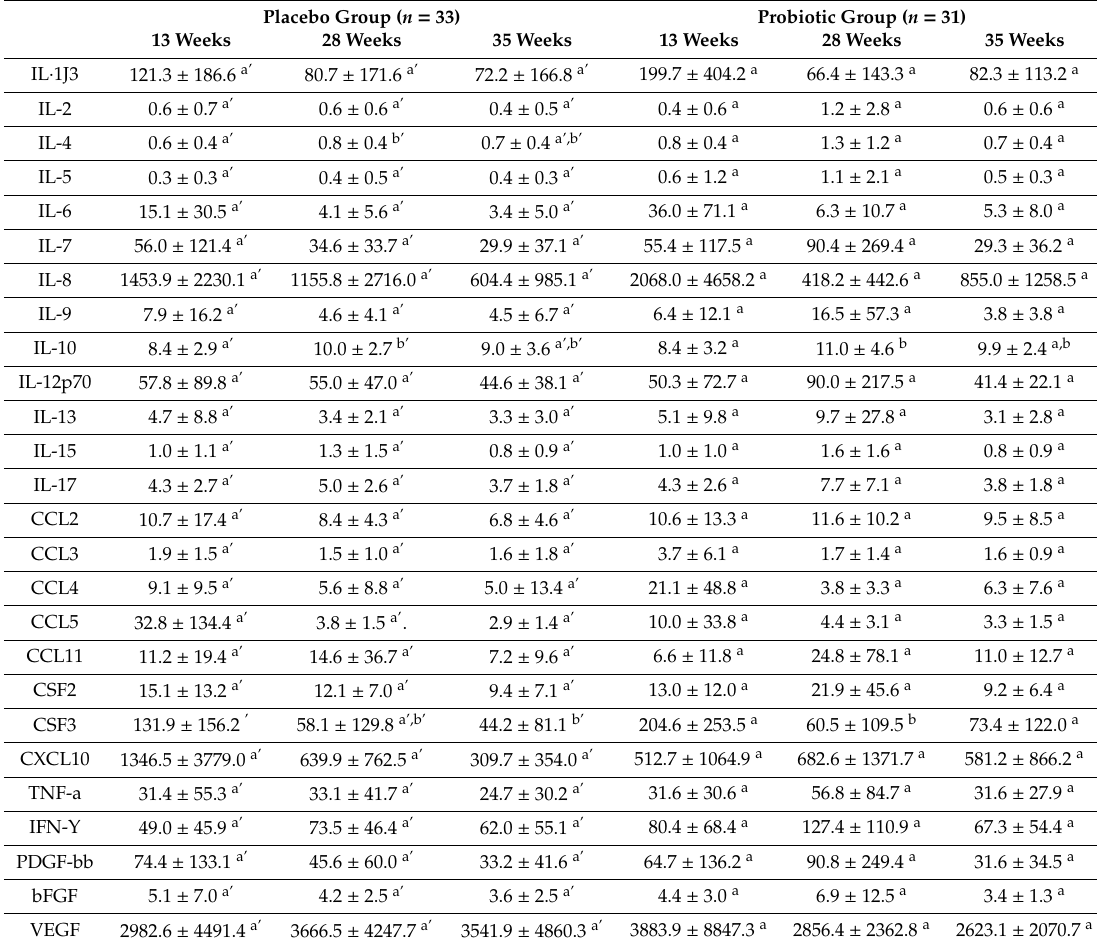
Table 5. Cervico-vaginal cytokines and chemokines across gestation in pregnant women who received either placebo or probiotic